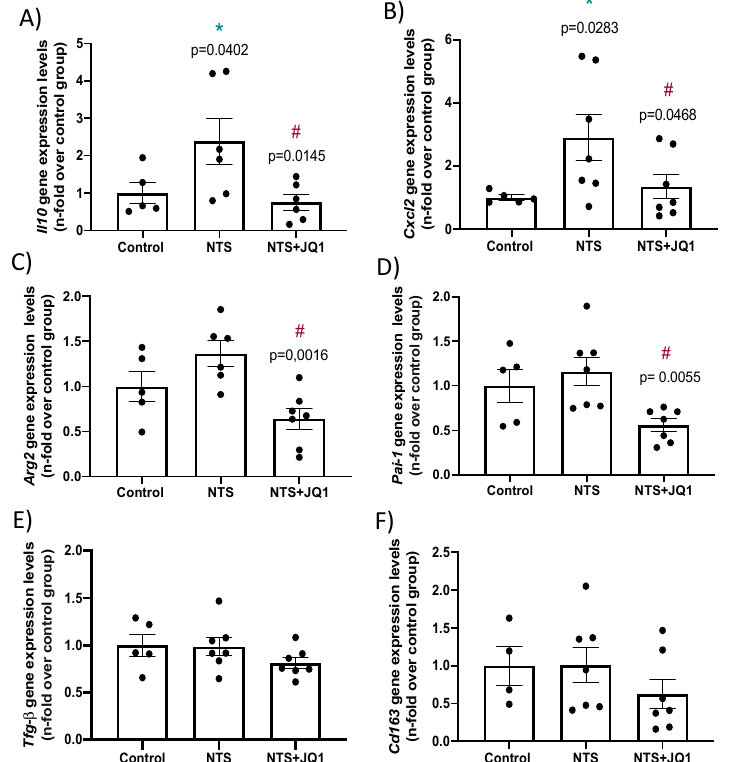
Figure 5 . Effect of BET inhibition on gene expression in nephrotoxic nephritis. RNA was isolated from frozen samples of whole kidney, IL10 ( A ) Cxcl2, ( B ) Cd163 ( C ) , Arg2 ( D ), Tgf- β ( E ) and Pai1 ( F ), and gene expression levels were evaluated by real-time qPCR. Data are expressed as the mean ± SEM of 5–7 animals per group. * p < 0.05 vs. control; # p < 0.05 vs. NTS-injected mice.